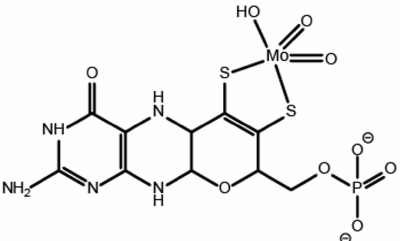
Figure 1. Structure of the molybdenum cofactor. The structure of the molybdenum cofactor (Moco) is shown. The Moco pterin part is shown in its fully reduced i.e., tetra-hydro form [13]. The first coordination sphere geometry of the Mo-center is shown as identified for Cnx1 E-domain bound Moco-AMP [14].